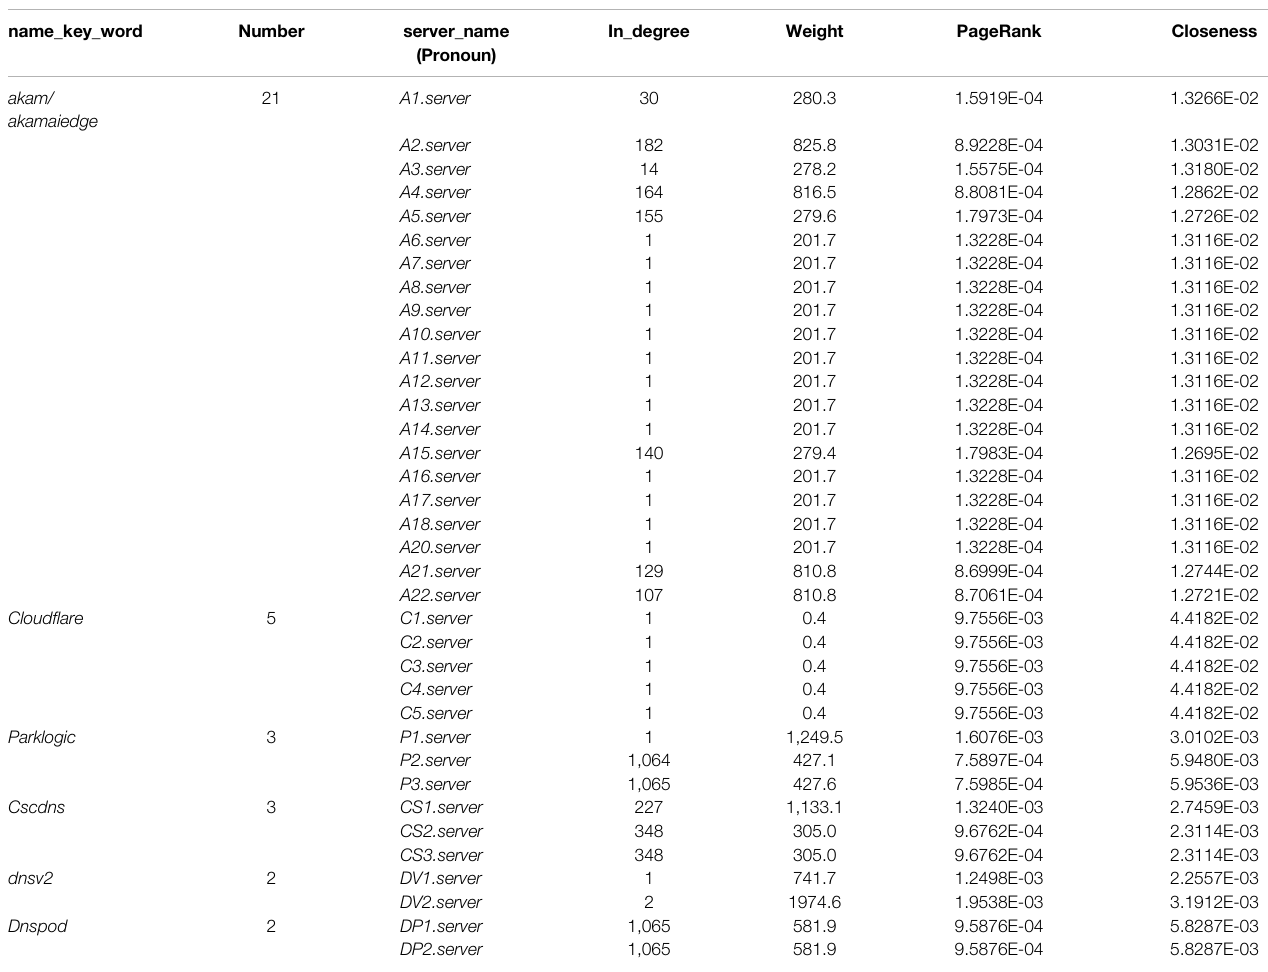
TABLE 4 | The in fl uential SLD name servers of N1 in the fi rst fi ve